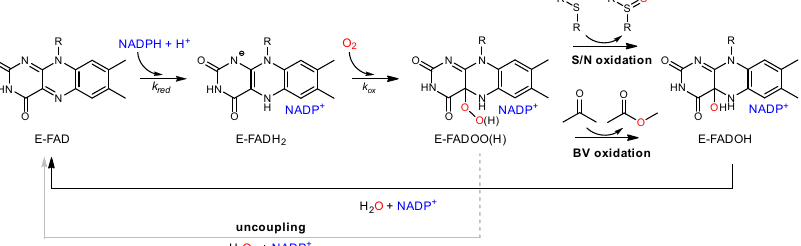
Fig. 1 | Catalytic mechanism of fl avin-containing monooxygenases. The recur- ring molecular structure represents the isoalloxazine moiety of the FAD cofactor where R corresponds to the ribityl adenosine tail. E stands for enzyme. First, oxi- dized FAD (E-FAD) is reduced by NADPH. The reduced enzyme (E-FADH 2 ) readily reacts with O 2 forming the oxygenating enzyme intermediate C4a- fl avin(hydro)